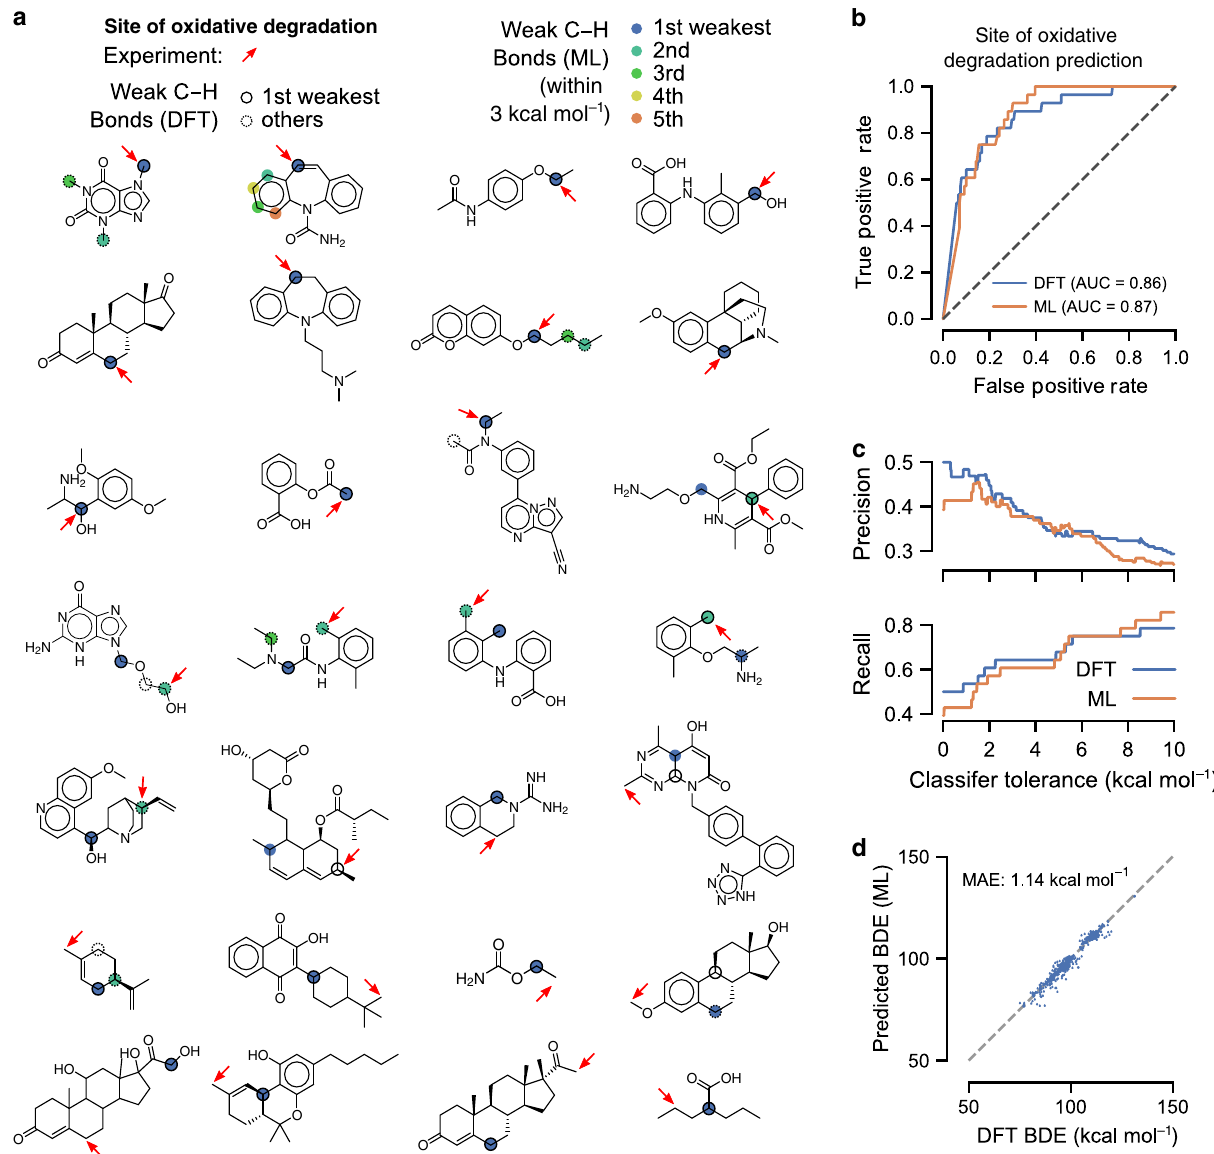
Fig. 7 Application of ALFABET to predict site of oxidative degradation. a Structures of many of drug molecules where the site of oxidative degradation is known. Arrows indicate the experimentally determined breaking bond, while colors and circles indicate weakest bonds determined by ML and DFT, respectively. ML-predicted weakest bonds identify the experimental site in 11 out of the 28 molecules. b ROC curve for classi fi ers that predict the metabolic site through BDEs generated through ML or DFT. Both approaches yield similar performance. c Precision and recall of classi fi ers based on bond strengths calculated via DFT and ML approaches. Potential metabolic sites included all C – H bonds within a given energy from a molecule ’ s minimum. d Accuracy of the ML method in predicting BDEs for 82 large, drug-like